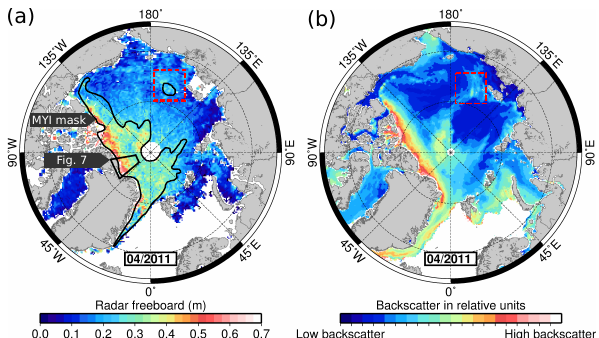
Figure 6. (a) CryoSat-2 mean radar freeboard of April 2011, re- trieved by applying the TFMRA40 retracker. It shows the area of co- incident validation flights in April 2011 (black box; see Fig. 7). (b) METOP ASCAT mean backscatter for April 2011. The red dashed box marks a common feature of (a) and (b)